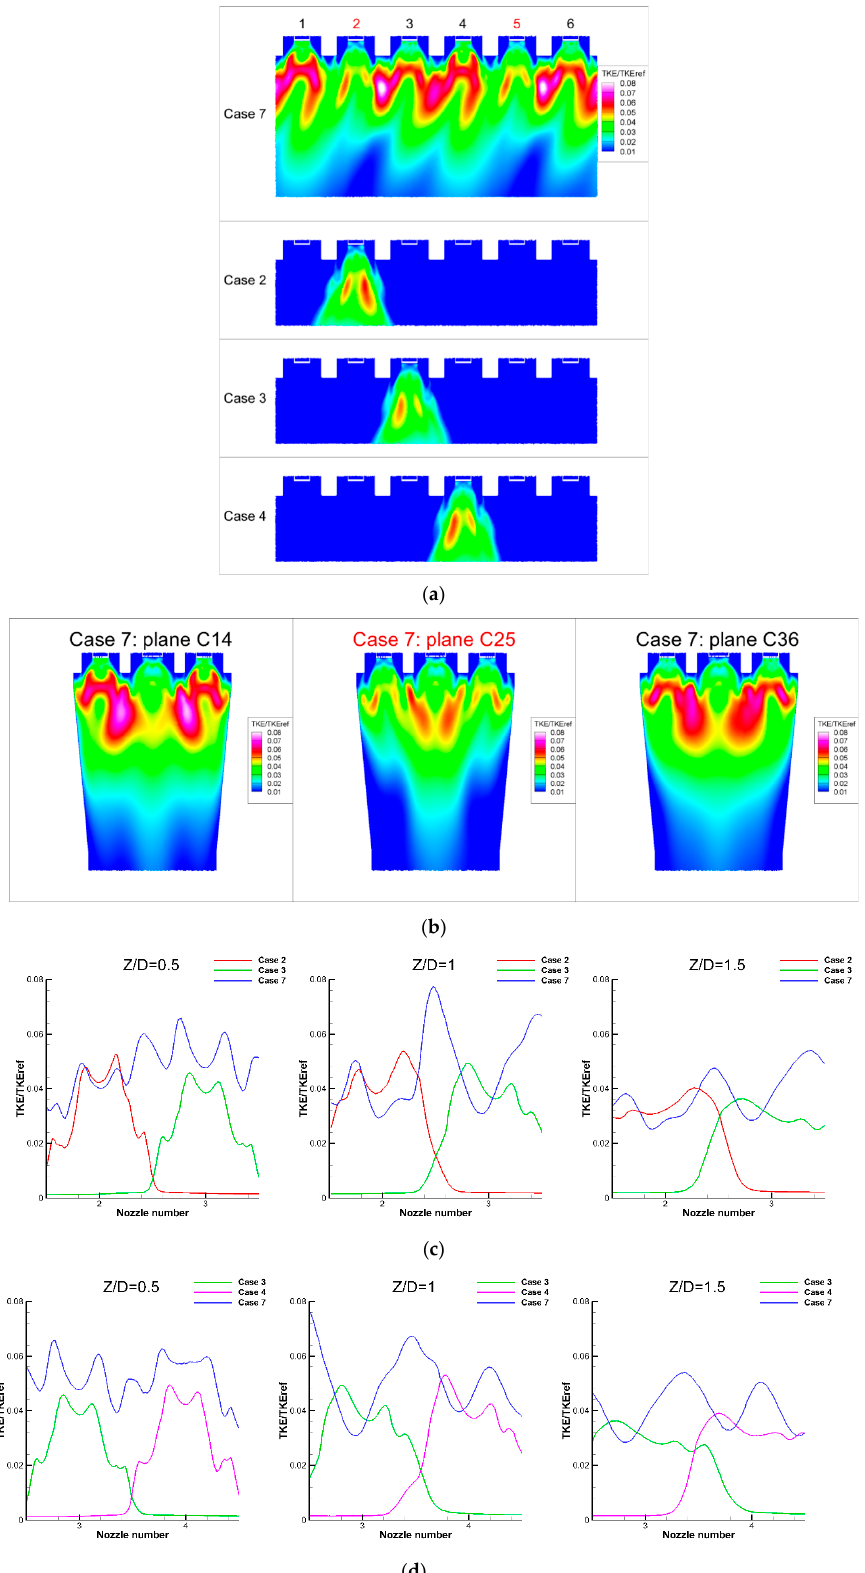
Figure 19. TKE information. ( a ) TKE on Iso-surface R/D = 1.6 in different cases; ( b ) TKE on different planes in Case 7; ( c ) TKE between nozzle 2 and 3 in Case 2, Case 3 and Case 7; ( d ) TKE between nozzle 3 and 4 in Case 3, Case 4 and Case 7.